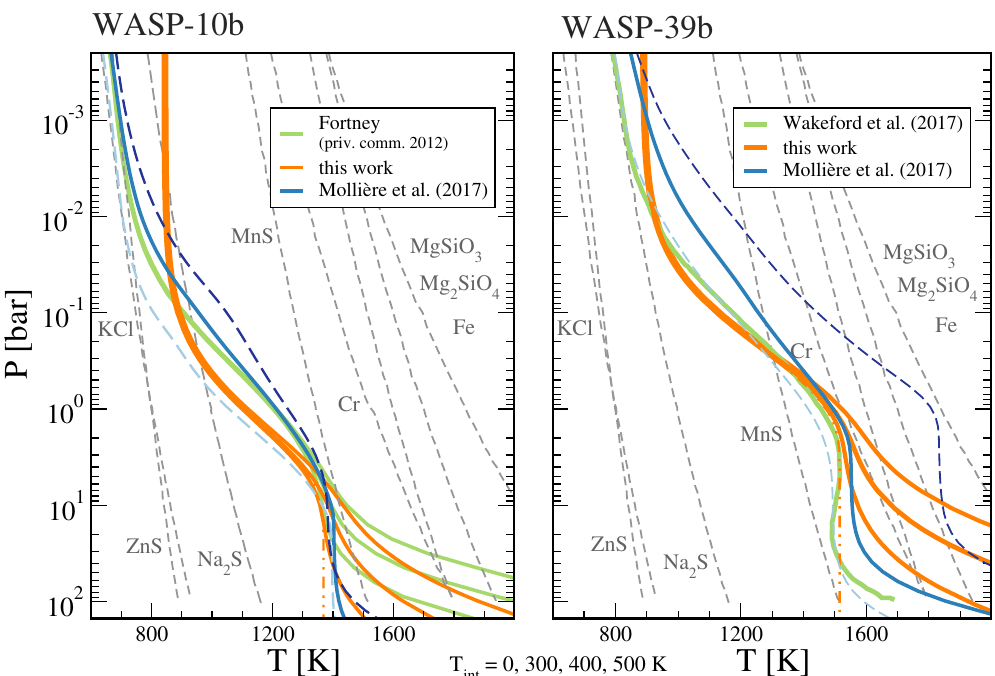
Figure 1. Condensation curves (grey dashed) of some species as labeled for solar-metallicity atmospheres (taken from Ref. [16]) and cloud-free P – T profiles (solid) for WASP-10b (left) and WASP-39b (right). Intersection points are possible cloud forming pressure levels. Orange P – T profiles are our fits to the profiles for WASP-10b from J. Fortney (pers. comm. 2012) as well as our fit to the global average profile of Wakeford et al. [2] for WASP-39b for different T int values. Additionally, we show the obtained clear profiles by Mollière et al. [17] for their deduced atmospheric enrichment in [Fe/H] (solid blue) and 10 × smaller vs. larger enrichment (dashed light blue vs. dashed dark